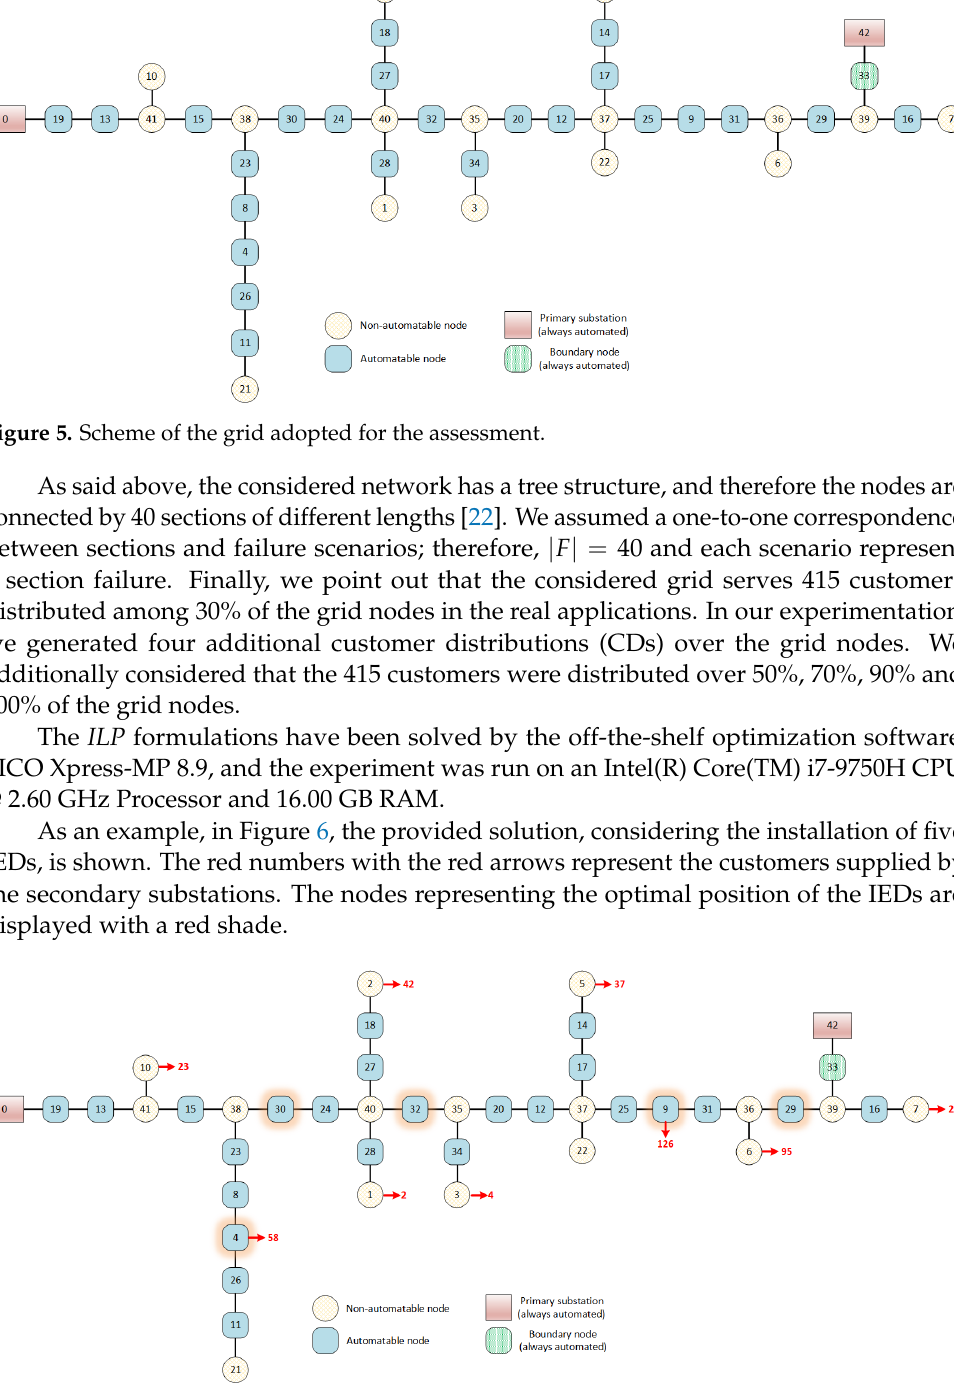
Figure 6. Optimal IED positions provided by